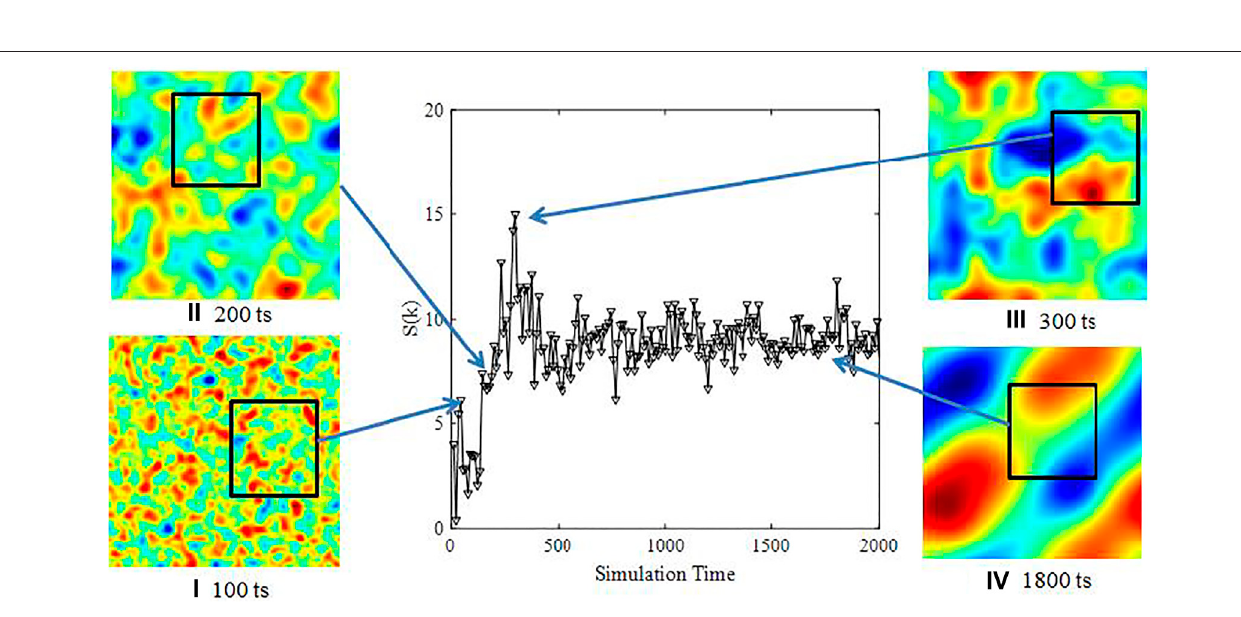
Frontiers in Earth Science |